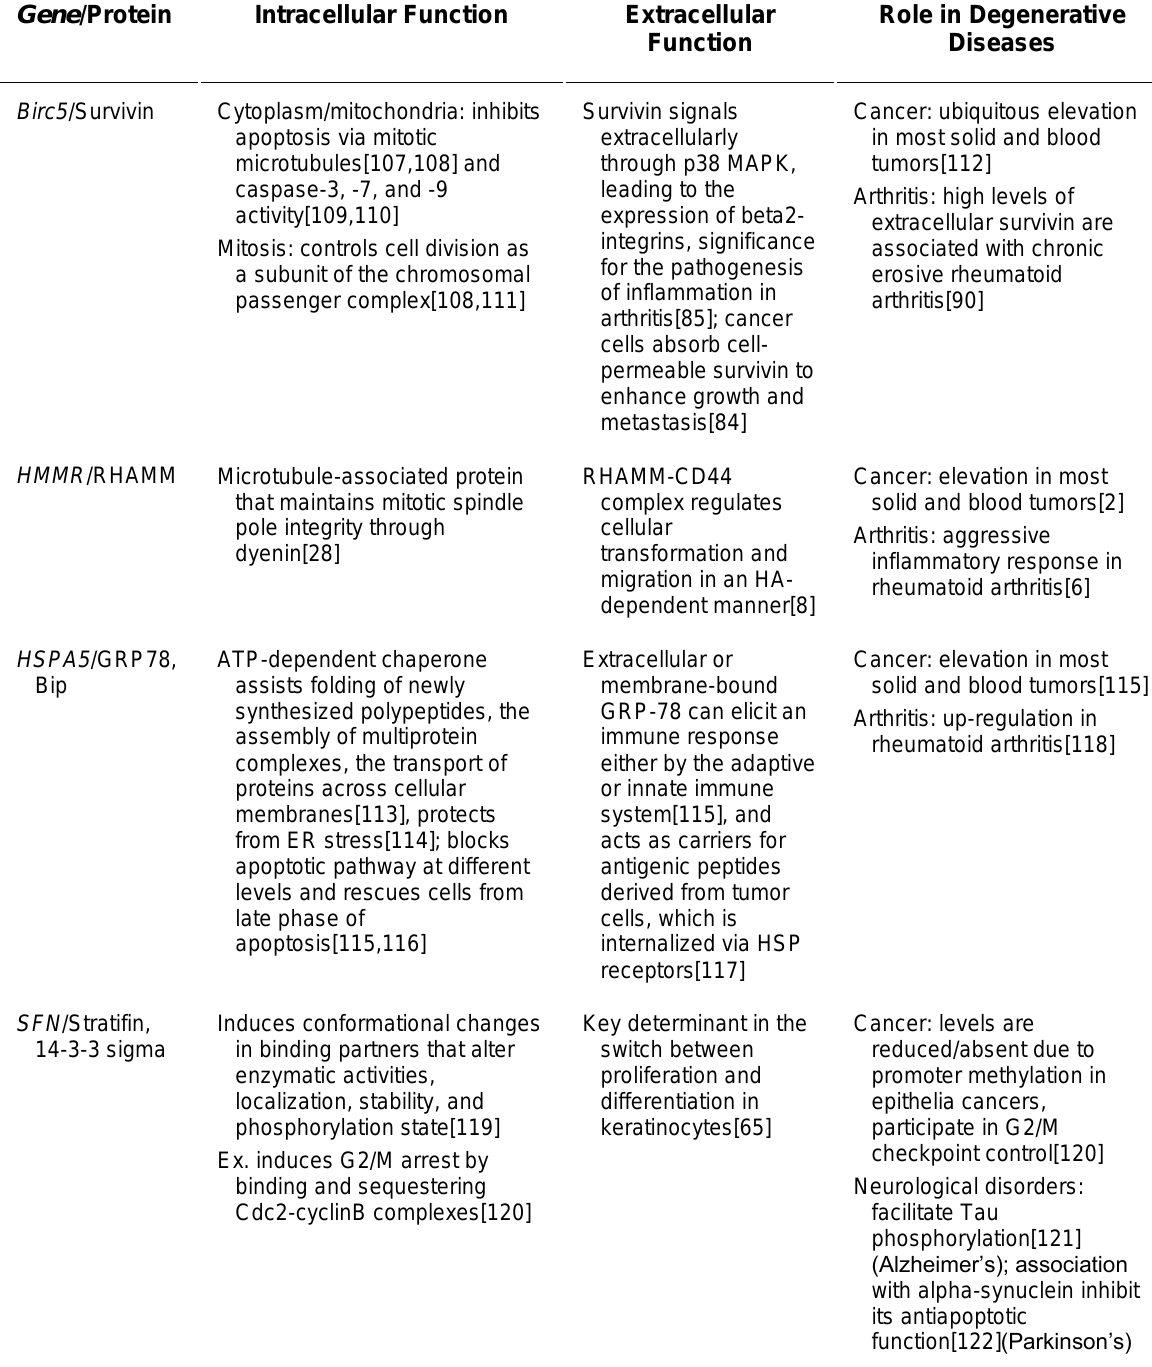
Multifunctional Proteins and Degenerative